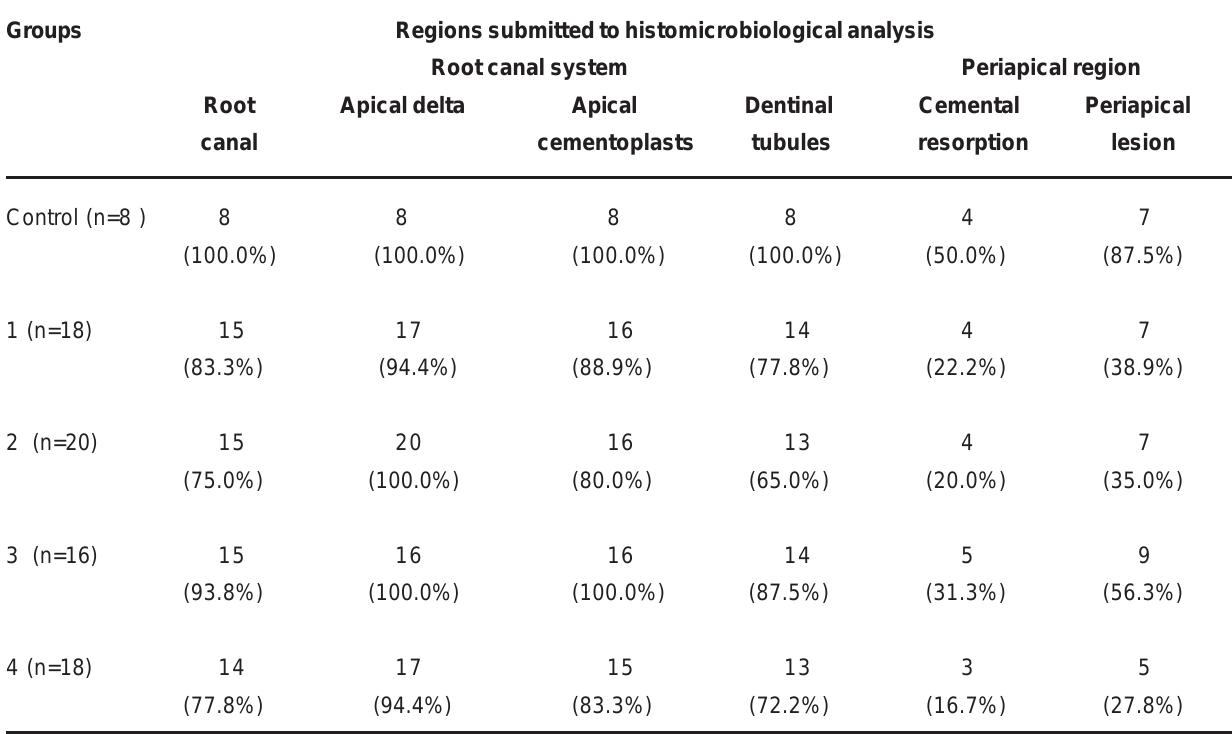
TABLE 1- Topographical distribution of microorganisms in the apical 3 mm of the root canal system and periapical region of each root of control and experimental groups